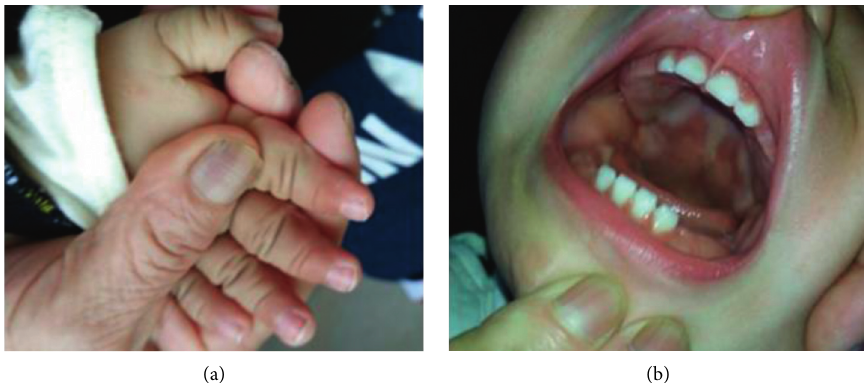
Figure 1: Photos of the current patient. (a) The short hand with mild nail dysplasia. The palm length of his left hand was 4.2cm and the finger length of his left hand was 2.6cm, with a total length of 6.8cm ( < 10 th percentile). The palm length of his right hand was 4.2cm and the finger length of his right hand was 2.5 cm, with a total length of 6.7cm ( < 10 th percentile). (b) Oral cavity. No signs of tooth abnormalities or multiple frenula.